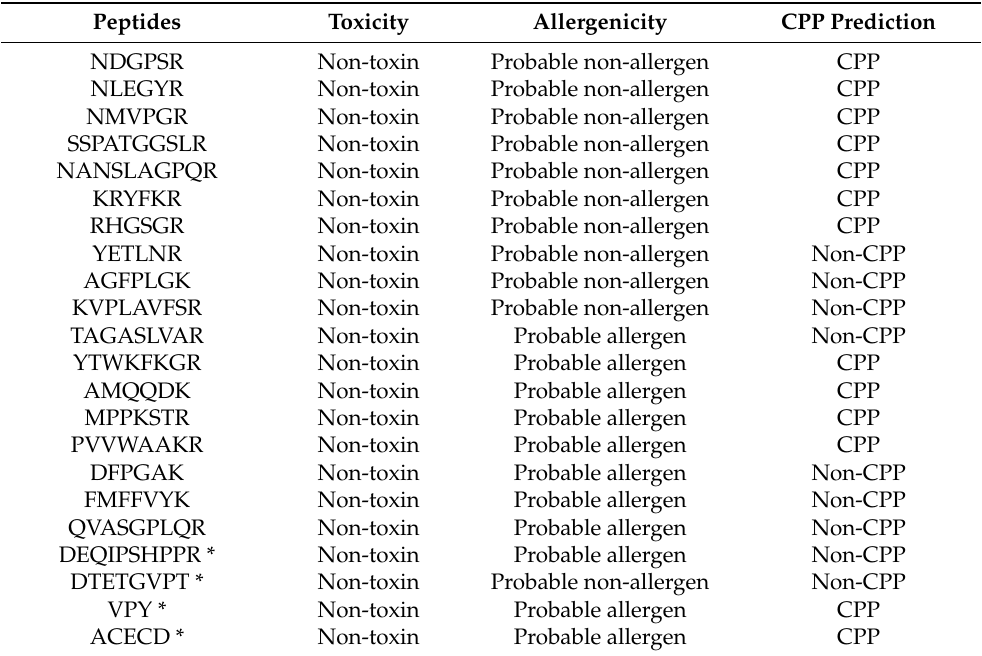
Table 5. Toxicity, allergenicity, and cell-penetrating ability predicted for selected corn silk peptides that have the same or higher affinity to Kelch-like ECH-associated protein 1, myeloperoxidase, and xanthine oxidase, in comparison with reference peptides.